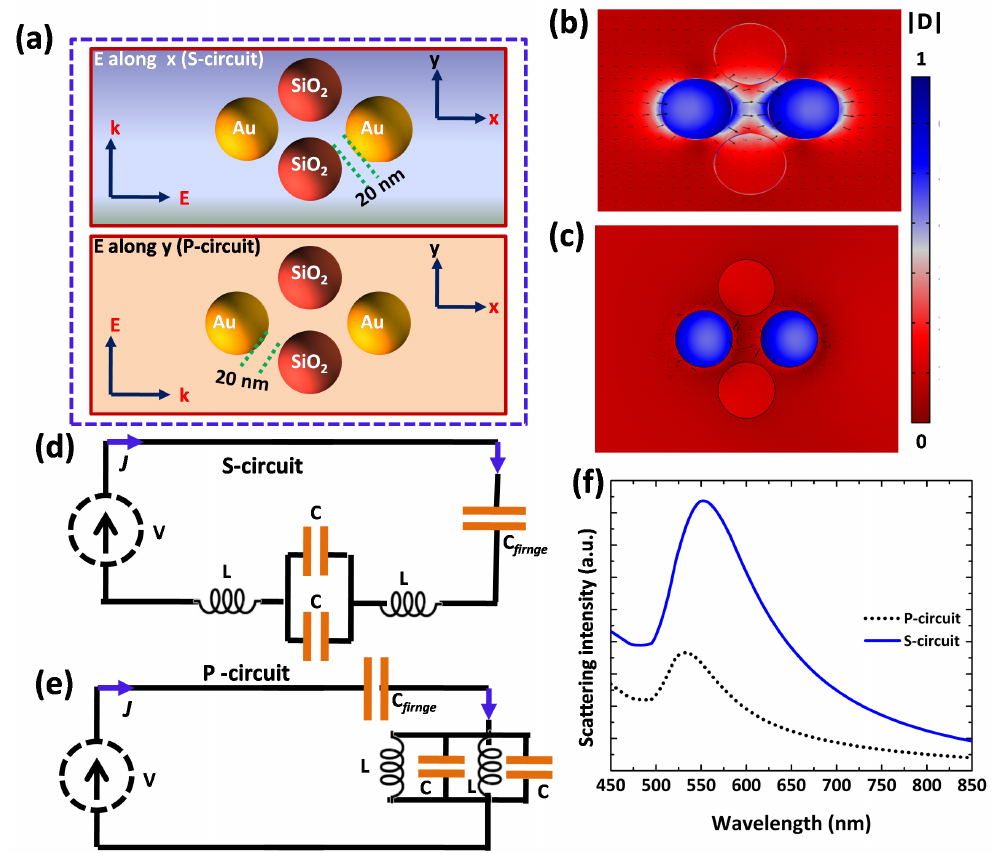
Figure 8. A fourth order lumped filter. ( a ) A schematic and geometry structure of a four NP complex nanocircuit composed of two silica nanospheres and two Au nanosphers for perpendicular and parallel cases of polarization. ( b ) The scattered displacement field calculated for s-polarized light shining the circuit with the incident field along x and localized field measured at the resonance (551 nm). ( c ) The simulated scattered displacement field for p-polarized light exciting the circuit with the E-field along y and response at the resonance (532 nm). ( d , e ) Thevenin nanocircuit models for S-circuit and P-circuit, respectively, representing lumped nanofilters. ( f ) The optical scattering spectrum for S-circuit (solid blue line) and P-circuit (black dotted